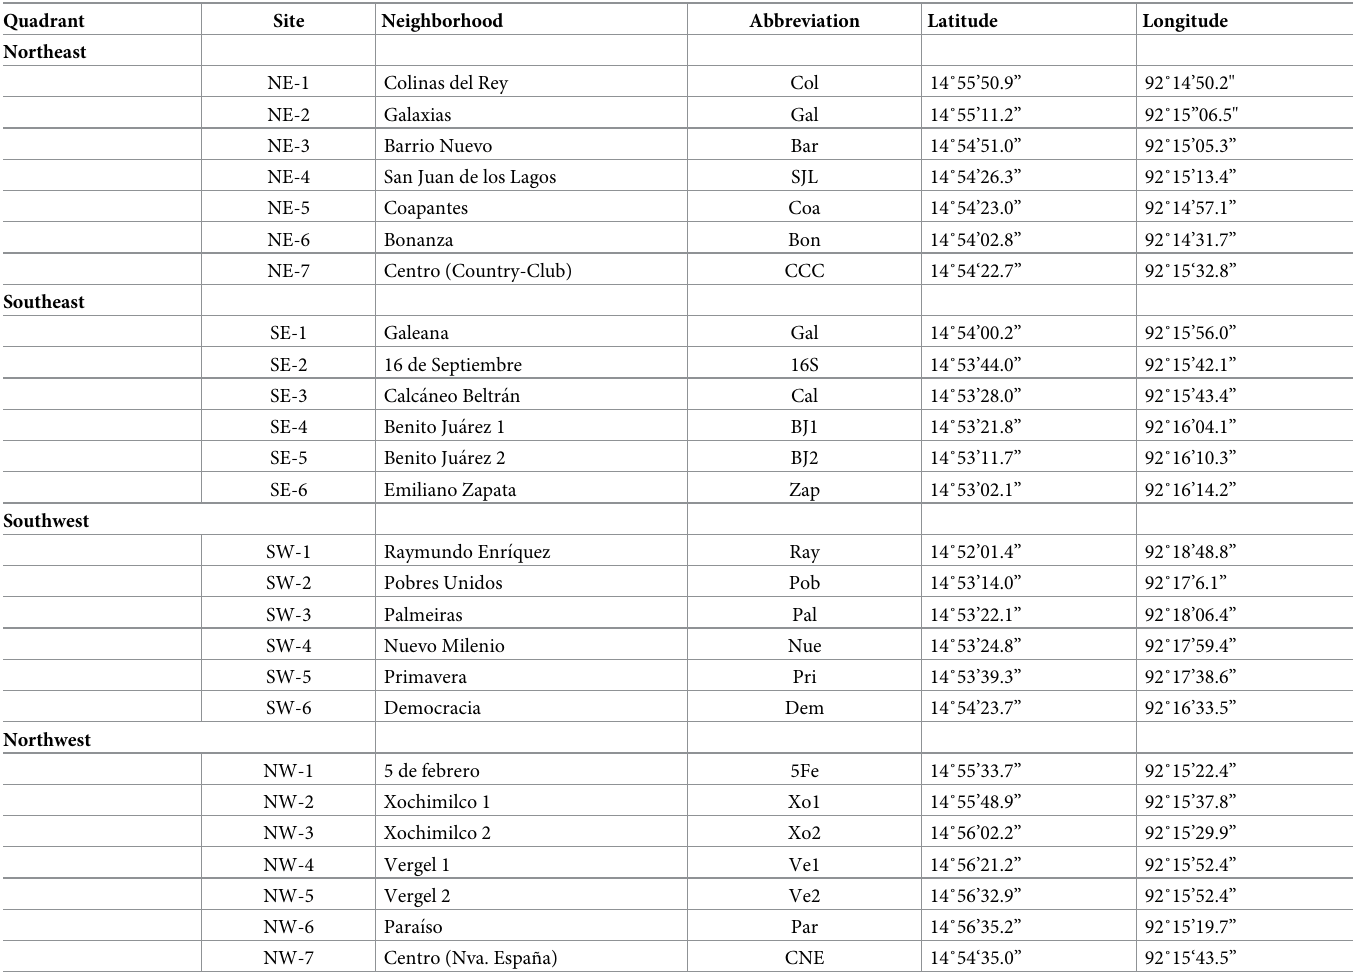
Table 1. Geographic location of 26 Aedes aegypti collection sites in Tapachula, Chiapas, Mexico, in 2018.